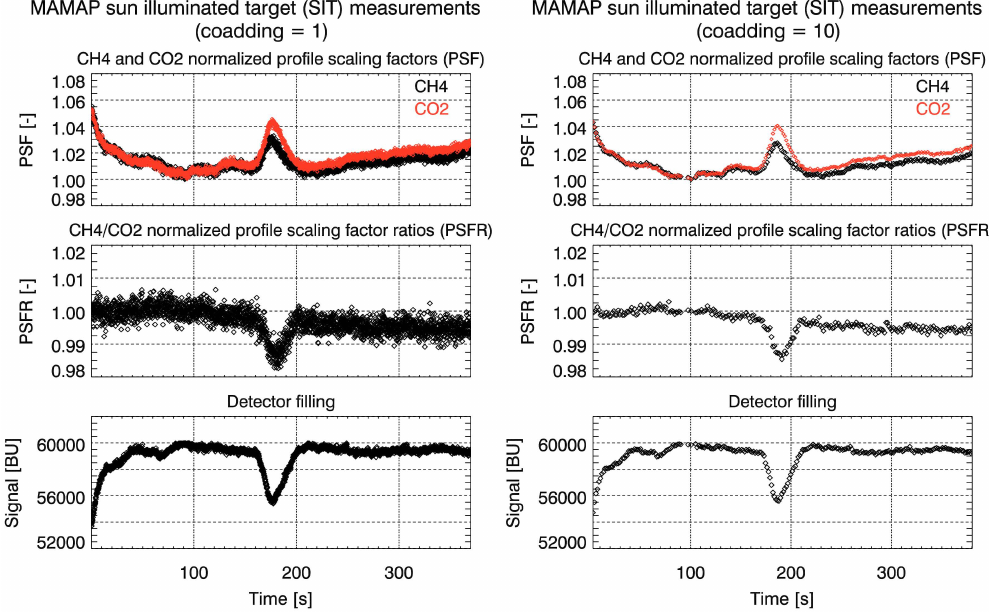
Fig. 7. Analysis of time series of MAMAP single detector readout CH 4 and CO 2 measurements (Left: for the 11 May 2006, Bremen stationary “on-ground” sun illuminated target, SIT, measurements, right: for the 10 May 2006 “on-ground” zenith sky scattered radiance, ZRG, measurements). Left: top panel: normalized CO 2 /CH 4 profile scaling factor ratios (PSFR i ). Second panel: maximum radiance (detector filling) in binary units [ BU ] as measured with MAMAP and digitalized with 16BitADC. Bottom panel: estimated signal-to-noise ratios (SNR) of the single measurements. Right: as on left side but for the zenith sky scattered radiance measurements (only measurements with > 3000 [ BU ] are